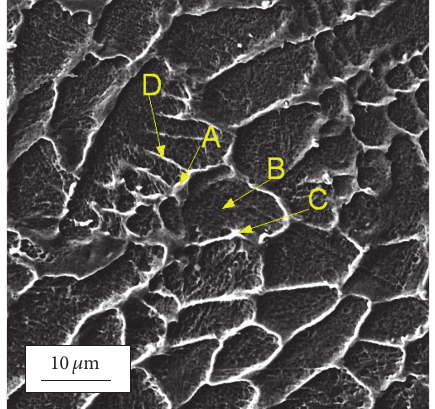
Figure 14: The EDS points to investigate microsegregation in subgrain boundary and subgrain spaces in the weld zone (sample number